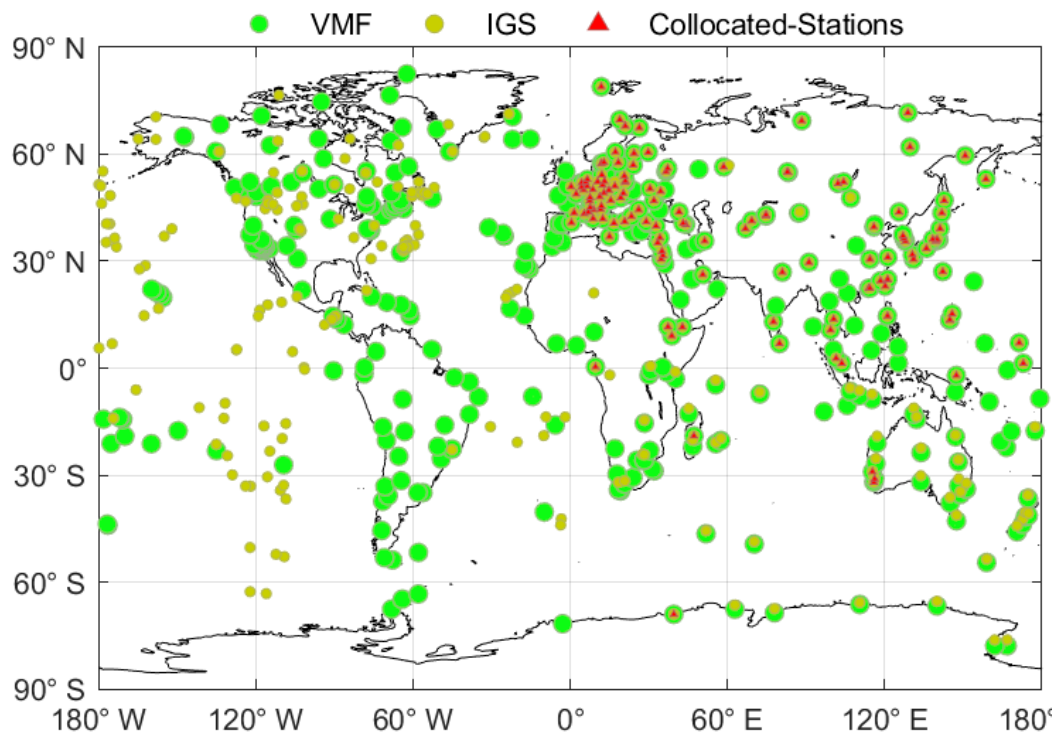
Figure 3. Global distribution of VMF and IGS